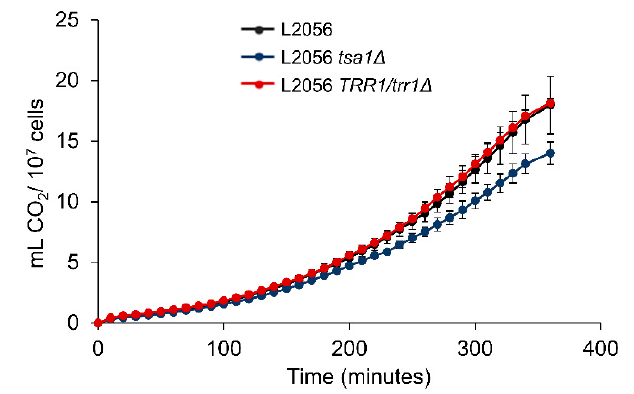
Figure 6. TSA1 is required for full fermentative capacity. The capacity fermentative of L2056, the